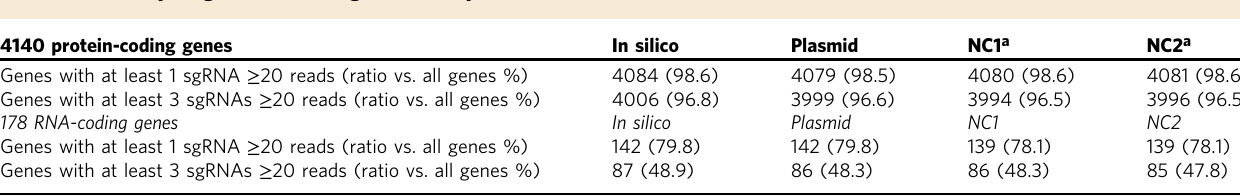
a Transformation with 20-fold coverage results in two biological replicates (NC1 and NC2)